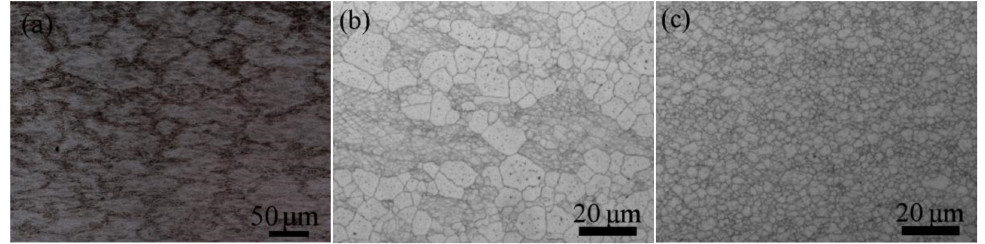
Figure 8. Microstructure in different locations: ( a ) A, ( b ) B, and ( c ) C.